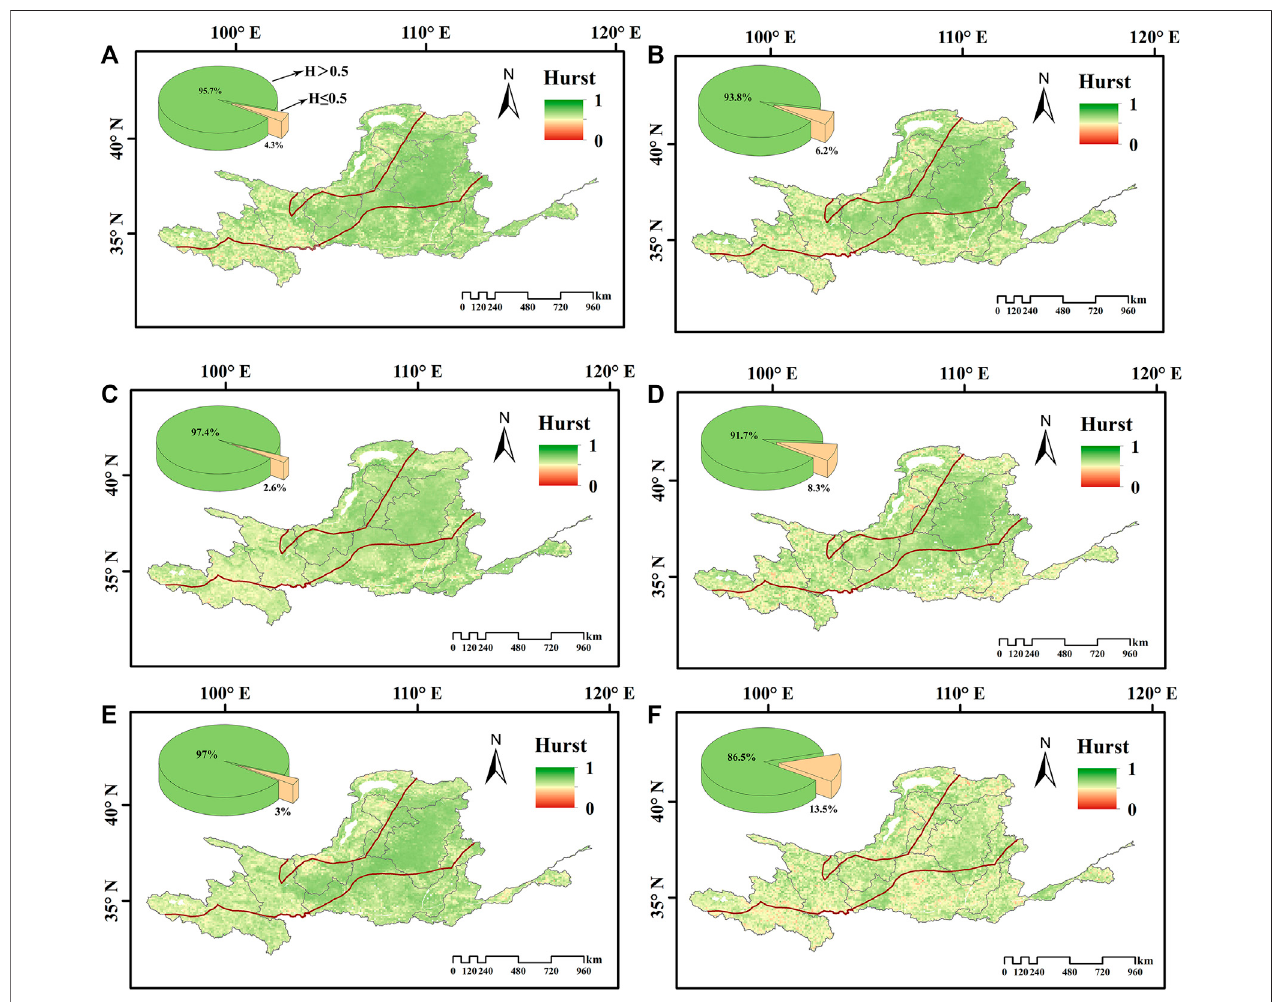
FIGURE 6 | Spatial distribution of Hurst index of NDVI in the Yellow River basin in (A) annual, (B) growing season, (C) spring, (D) summer, (E) autumn, and (F) winter.